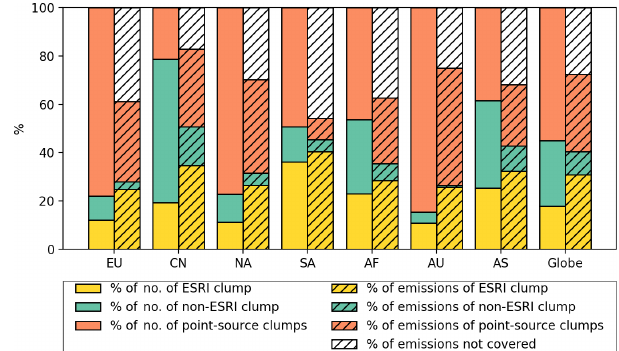
Figure 6. The fraction of the number (bars) and the fraction of emissions (hatched bars) found in the three types of clumps for the European continent (European Russia included), China, North America (NA), South America (SA), Africa, Australia, Asia with China excluded (AS), and over the globe. The three colors repre- sent ESRI clumps (yellow), non-ESRI clumps (green), and point- source clumps (red). The white-hatched bars indicate the fraction of ODIAC emissions that are not allocated to any clump by the al-